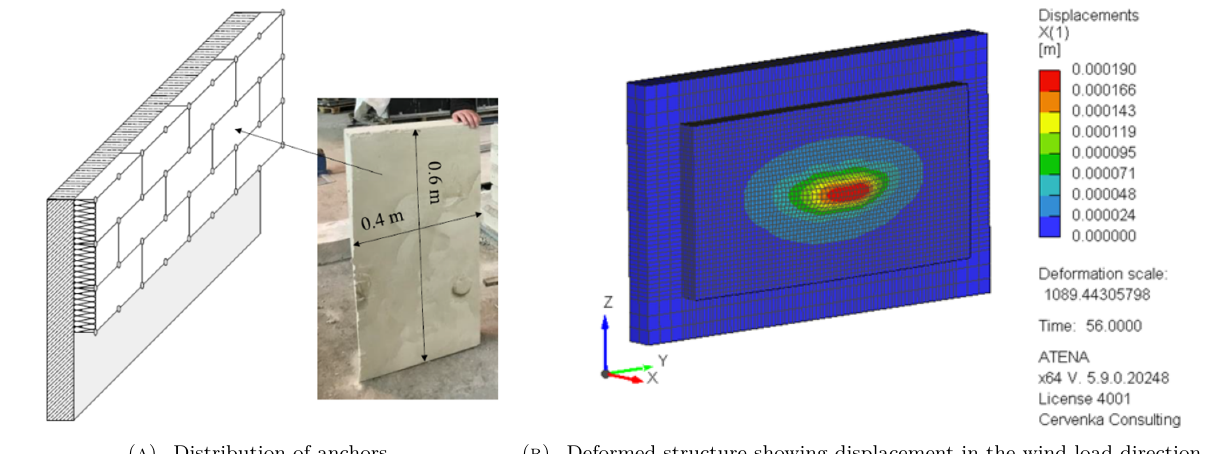
Figure 9. Wall structure with attached insulation tested for wind load.